Question: Summarize what this figure shows in one sentence.
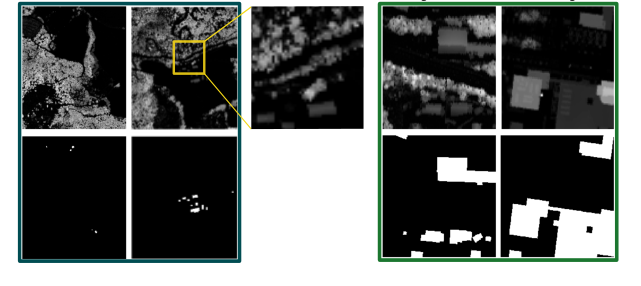
Answer: Scale differences as seen in our datasets. The top row shows LiDAR images at different scales from the train (left) and test (right) datasets. The corresponding building labels are shown in the bottom row. Even though our approach is pretrained for terrain-recovery on images as seen on the left, it translates easily to building with scales and sizes as seen on the right, indicating generalizability to objects at different scales (The magnification is to enable visual comparison between the two scales and aid reader comprehension and is not drawn to scale).